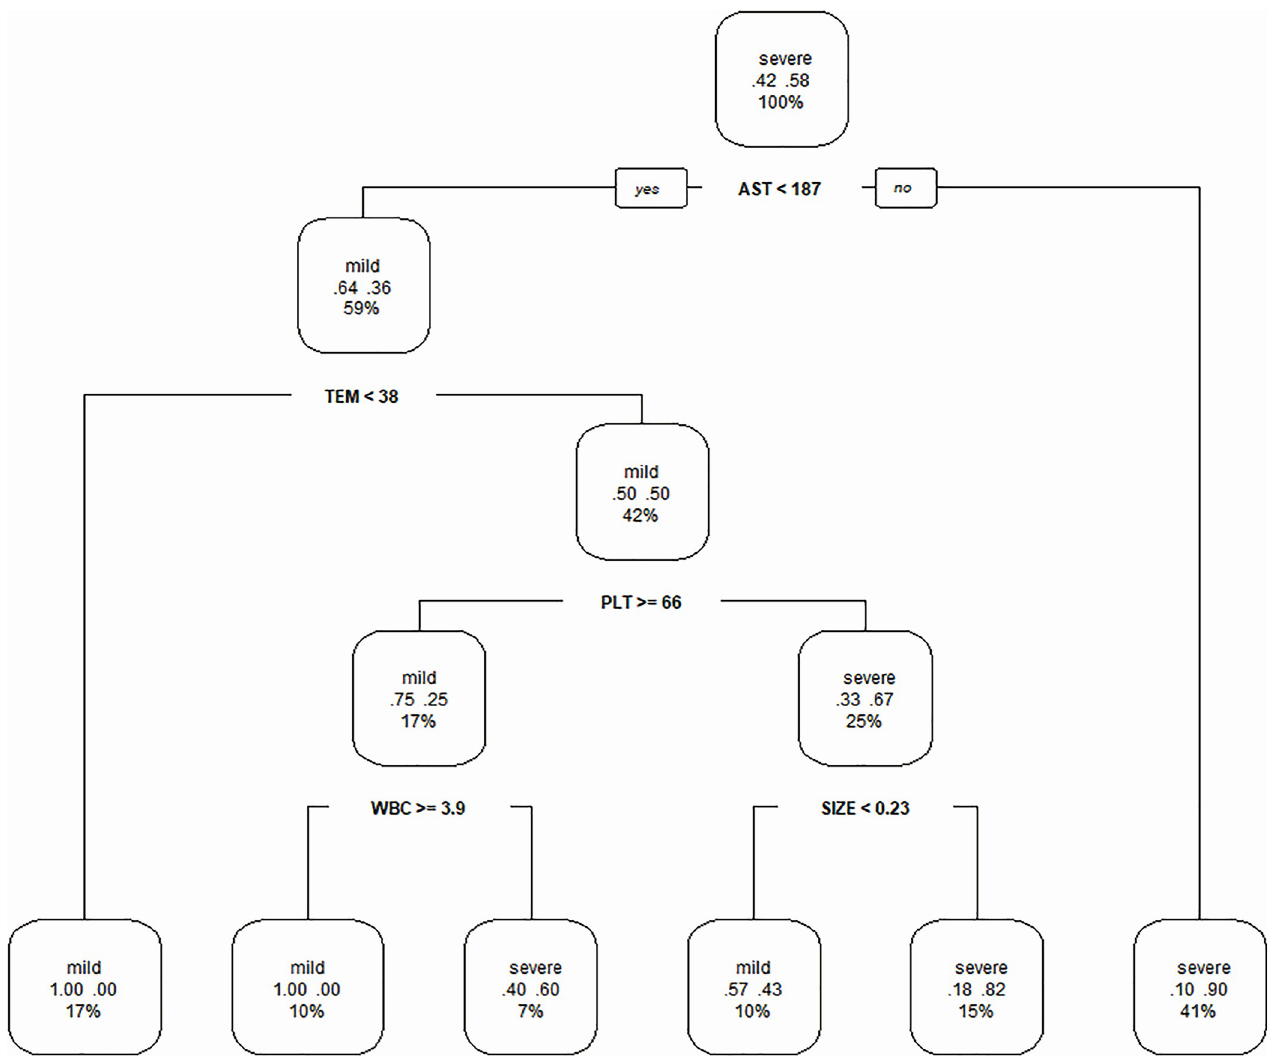
Fig 2. Decision tree based on laboratory parameters of SFTS patients. TEM = body temperature; SIZE = size of lymphadenectasis.